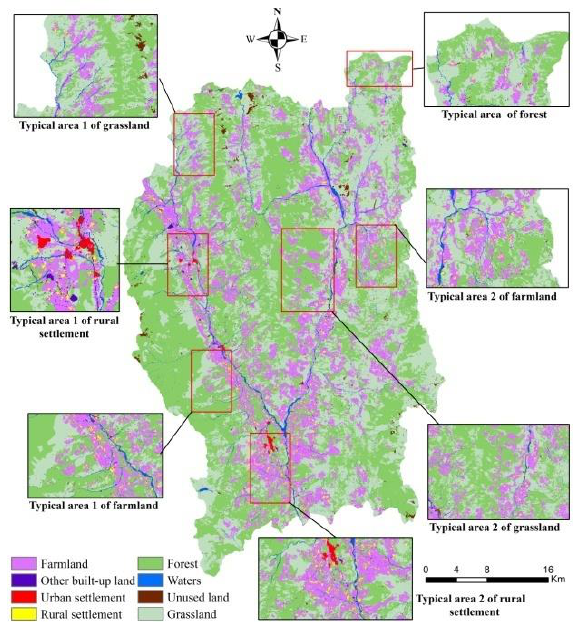
Figure 10. Spatial distribution of land use under the trenddevelopment scenario in 2030.